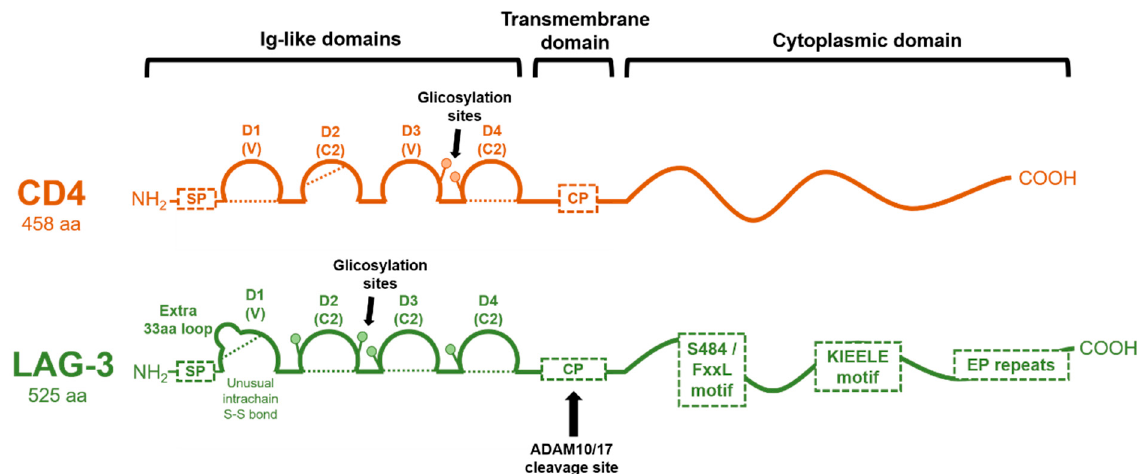
Figure 2. Molecular organization of CD4 and LAG-3 proteins. The domain organization of CD4 and LAG-3 is schematically shown in the figure, with each Ig-like domain indicated as arcs. Dotted lines represent disulfide bonds. The cleavage site for ADAM 10/17 in LAG-3 is shown, rendering a soluble version. CP: connecting peptide; SP: signal peptide.